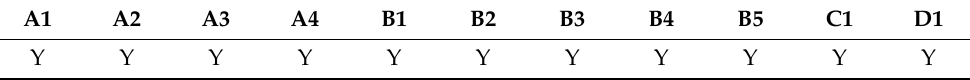
Table 5. Analysis result of meeting the requirements of the proposed